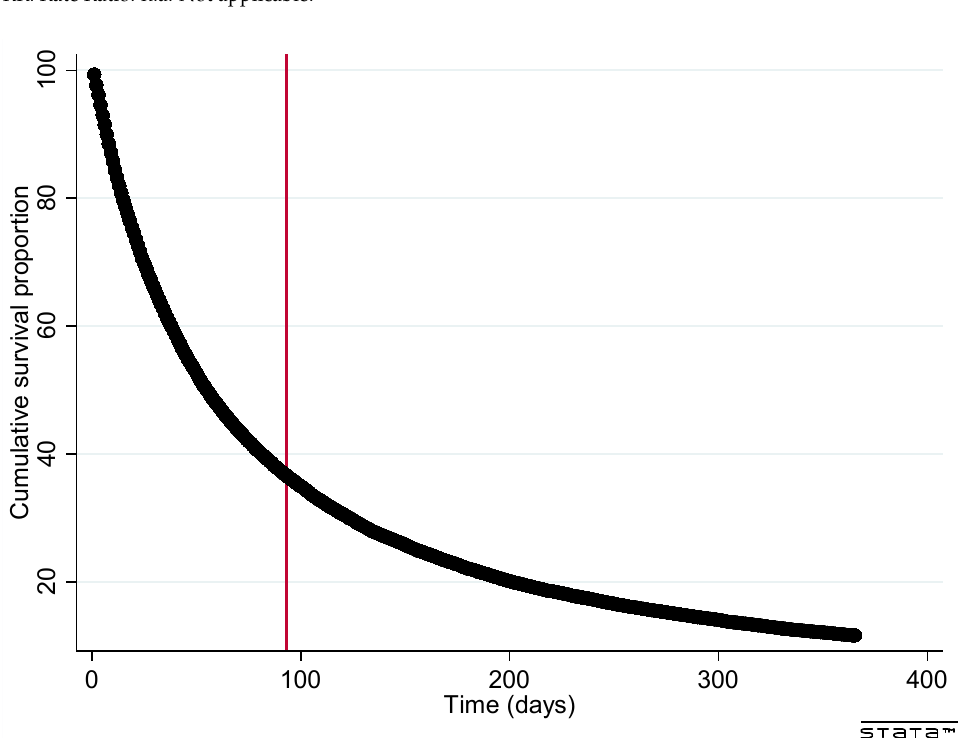
Figure 3. Survival curve for patients initiating SPC